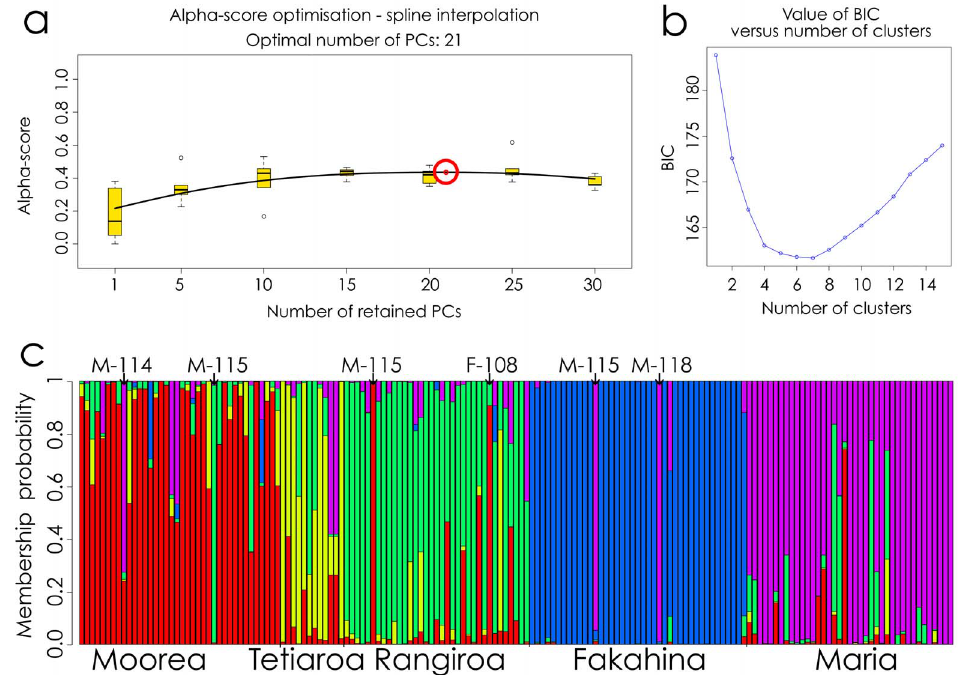
Figure 2. Bayesian approach results using the Discriminant Analysis of Principal Components to investigate genetic structure. The optimal number of principal components found for the analysis was 21 based on the trend in alpha scores (a). The BIC (Bayesian Information Criterion) values are shown in relation to the number of genetic clusters in (b). Each vertical bar represents an individual in the DAPC diagram (compoplot) shown as (c), and each color represents the probability of belonging to one of the genetic clusters. Some outliers have been noted on the top of the figure: M=male, F=female, followed by the total length of each shark in cm.